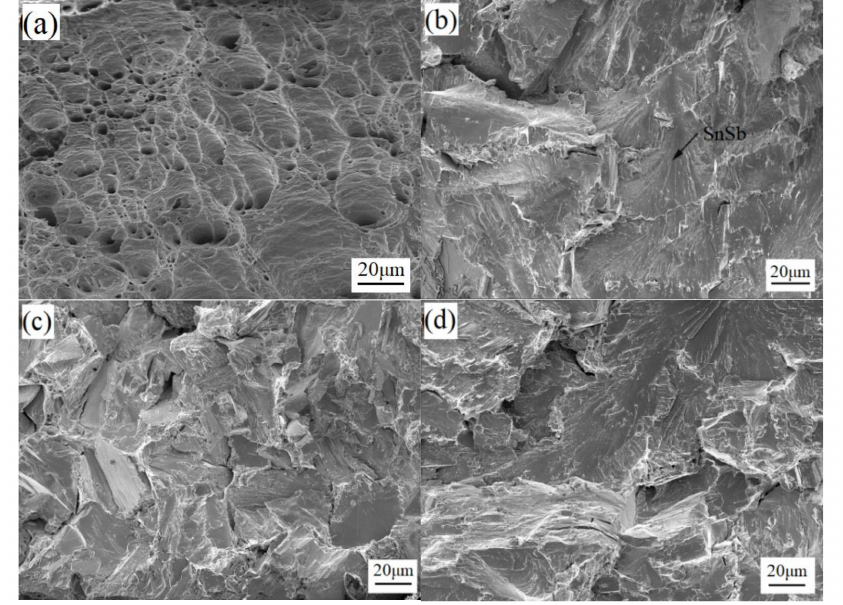
Figure 10. Microscopic fracture surface of ( a ) Sn-3.0Ag-0.5Cu, ( b ) Sn-3.0Ag-0.5Cu-25Sb, ( c ) Sn-3.0Ag-0.5Cu-28Sb, and ( d ) Sn-3.0Ag-0.5Cu-31Sb.